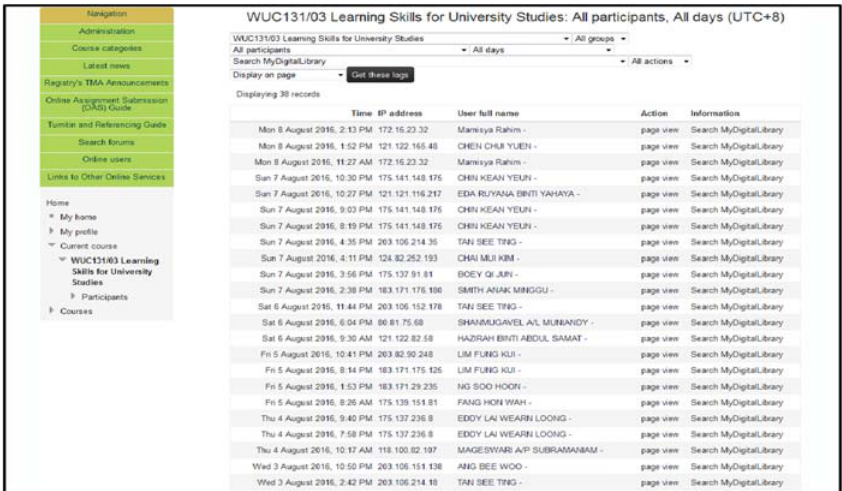
Figure 9. Analytics of users accessing the library space in LMS